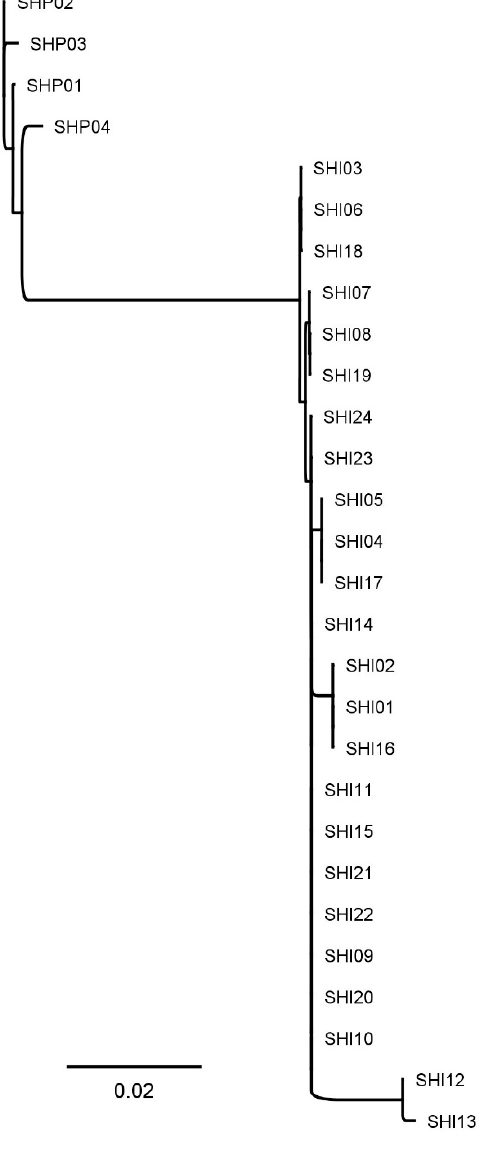
Figure 2. Neighbor-joining tree of marinka from DNA barcode sequences.